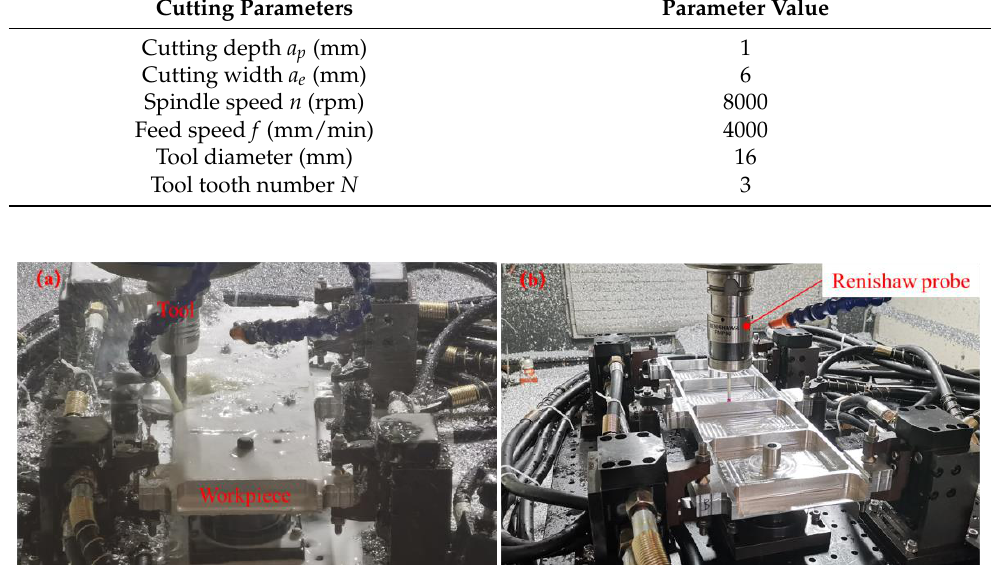
Figure 11. Experiment and measurement: ( a ) milling operation; ( b ) measuring deformation.